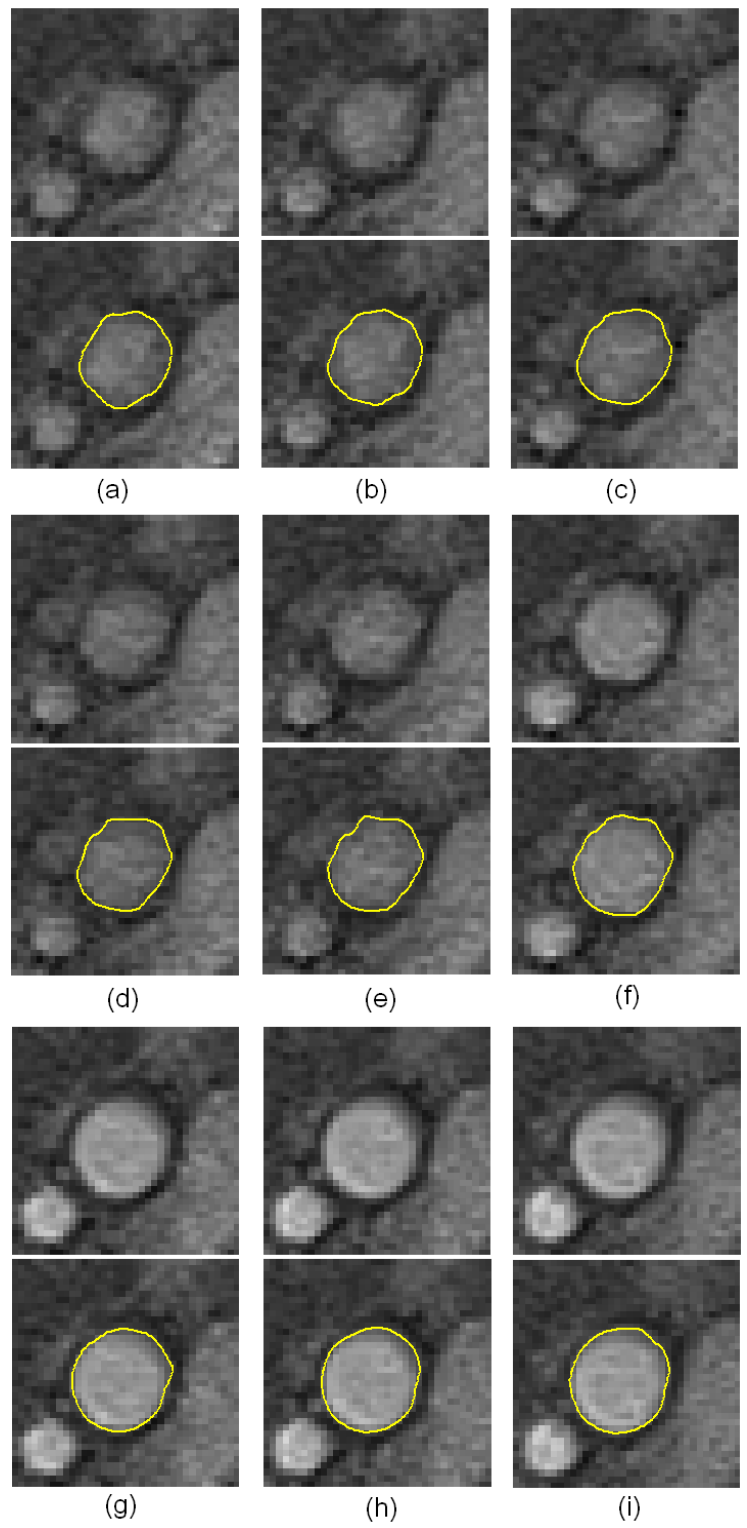
Figure 9. Boundary detection results. Nine sequential resultant images are shown. The vessel boundaries are vague in the first five images.Their exact boundaries are difficult to determine. Based on the continuity consideration in three dimensions, the proposed method can detect the correct vessel